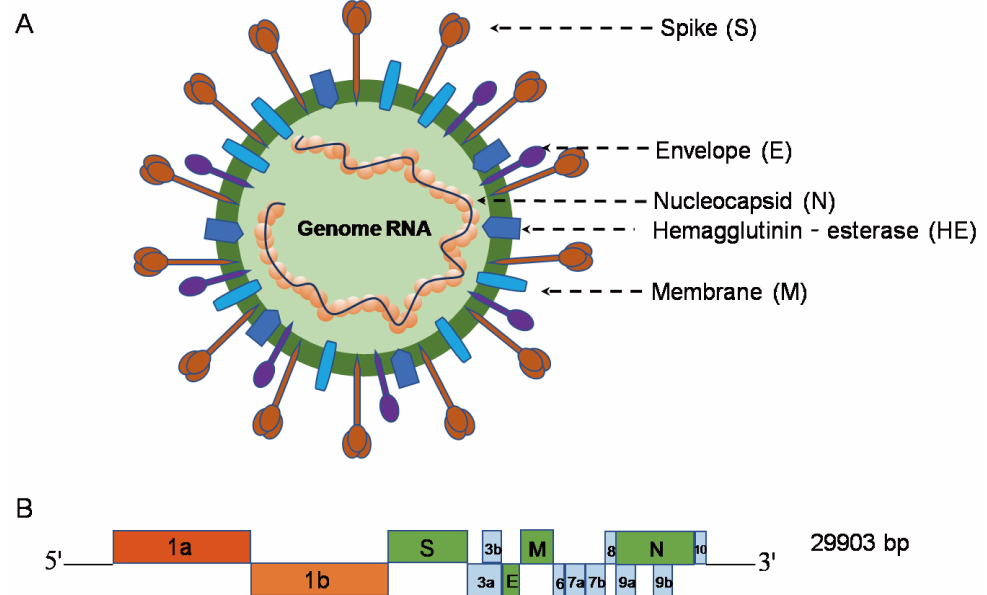
Figure 2. β -coronavirus particle and genome [9] ( A ) The β -coronavirus particle. β -coronavirus is an enveloped, nonsegmented, positive-sense single-stranded RNA virus genome in a size ranging from 29.9 kb. The virion has a nucleocapsid composed of genomic RNA and phosphorylated nucleocapsid (N) protein, which is buried inside phospholipid bilayers and covered by the spike glycoprotein trimmer (S). The membrane (M) protein hemagglutinin-esterase (HE) and the envelope (E) protein are located among the S proteins in the virus envelope. ( B ) 5 (cid:48) and 3 (cid:48) terminal sequences of the SARS-CoV-2 genome. The gene order is 5 (cid:48) -replicase ORF1ab-S-envelope(E)-membrane(M)-N-3 (cid:48) . ORF3ab, ORF6, ORF7ab, ORF8, ORF9ab, and ORF10 are located at the predicted positions shown in the picture. 1a, 1b, 3a, 3b, 6, 7a, 7b, 8, 9a, 9b, 10 in the picture represent di ff erent ORF